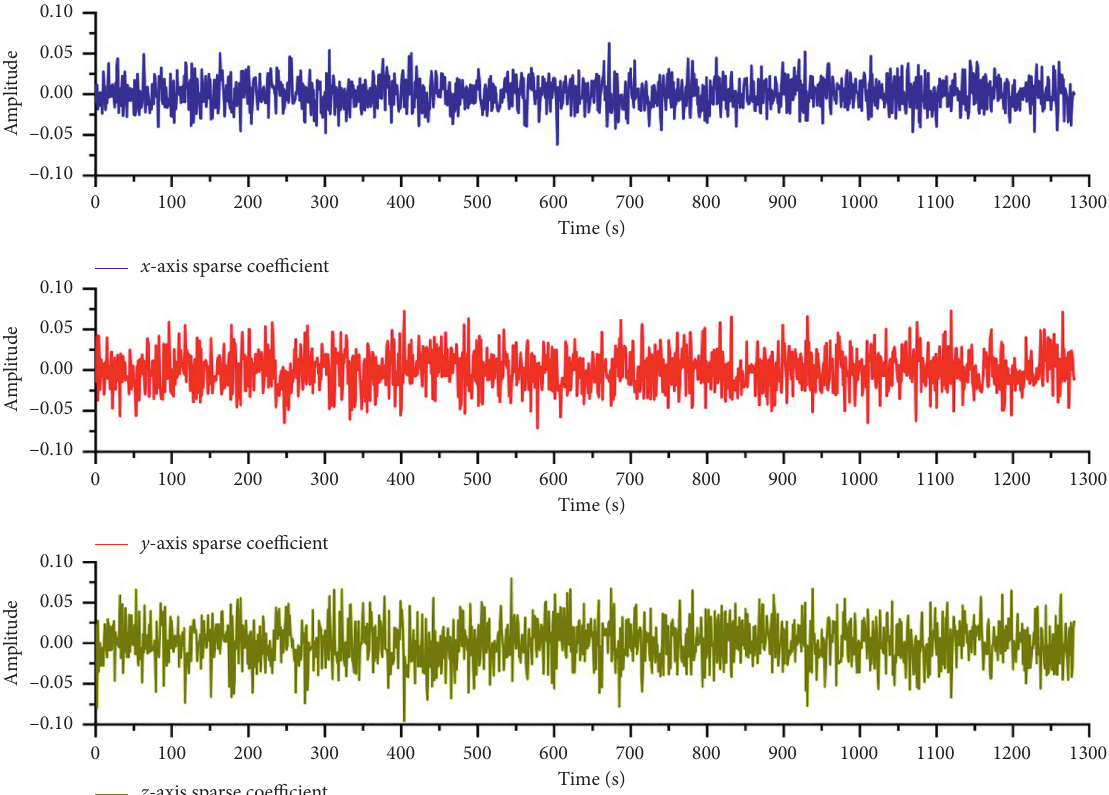
Figure 6: Sparse vectors in three axial